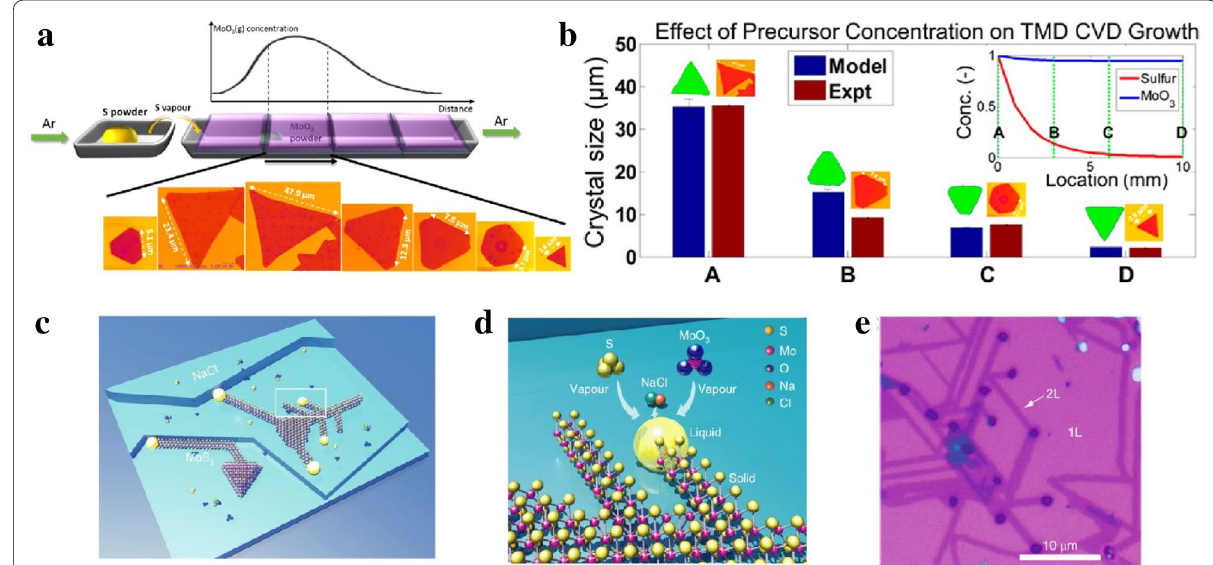
Fig. 5 Morphology control of TMDs materials. a MoS 2 CVD growth system. The optical images show the MoS 2 with various sizes and shapes [84]. Copyright 2014, American Chemical Society. b Effects of precursors concentration on the sizes and shapes of TMDs during CVD growth measured by both theoretically and experimentally [85]. Copyright 2016, American Chemical Society. c , d MoS 2 ribbons grow on NaCl crystal surface via VLS mode. e Optical image of